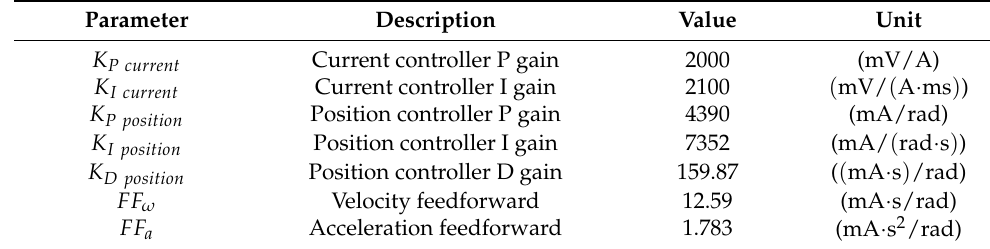
Table 3. Electric motor controller